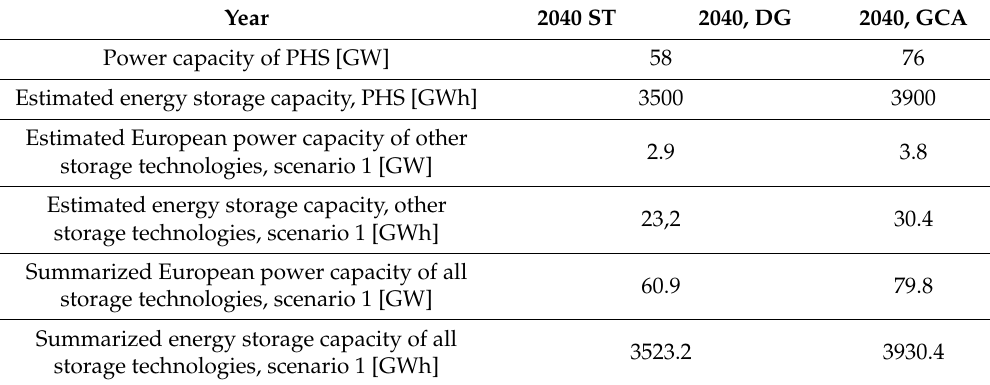
Table 7. Power capacity and energy storage capacity results of the European energy storage systems